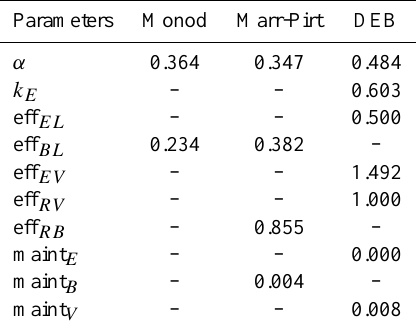
Table 3. Parameter values for each of the three models for experiment P. Parameters were estimated by the minimisation of the sum of squared deviations of model predictions to data